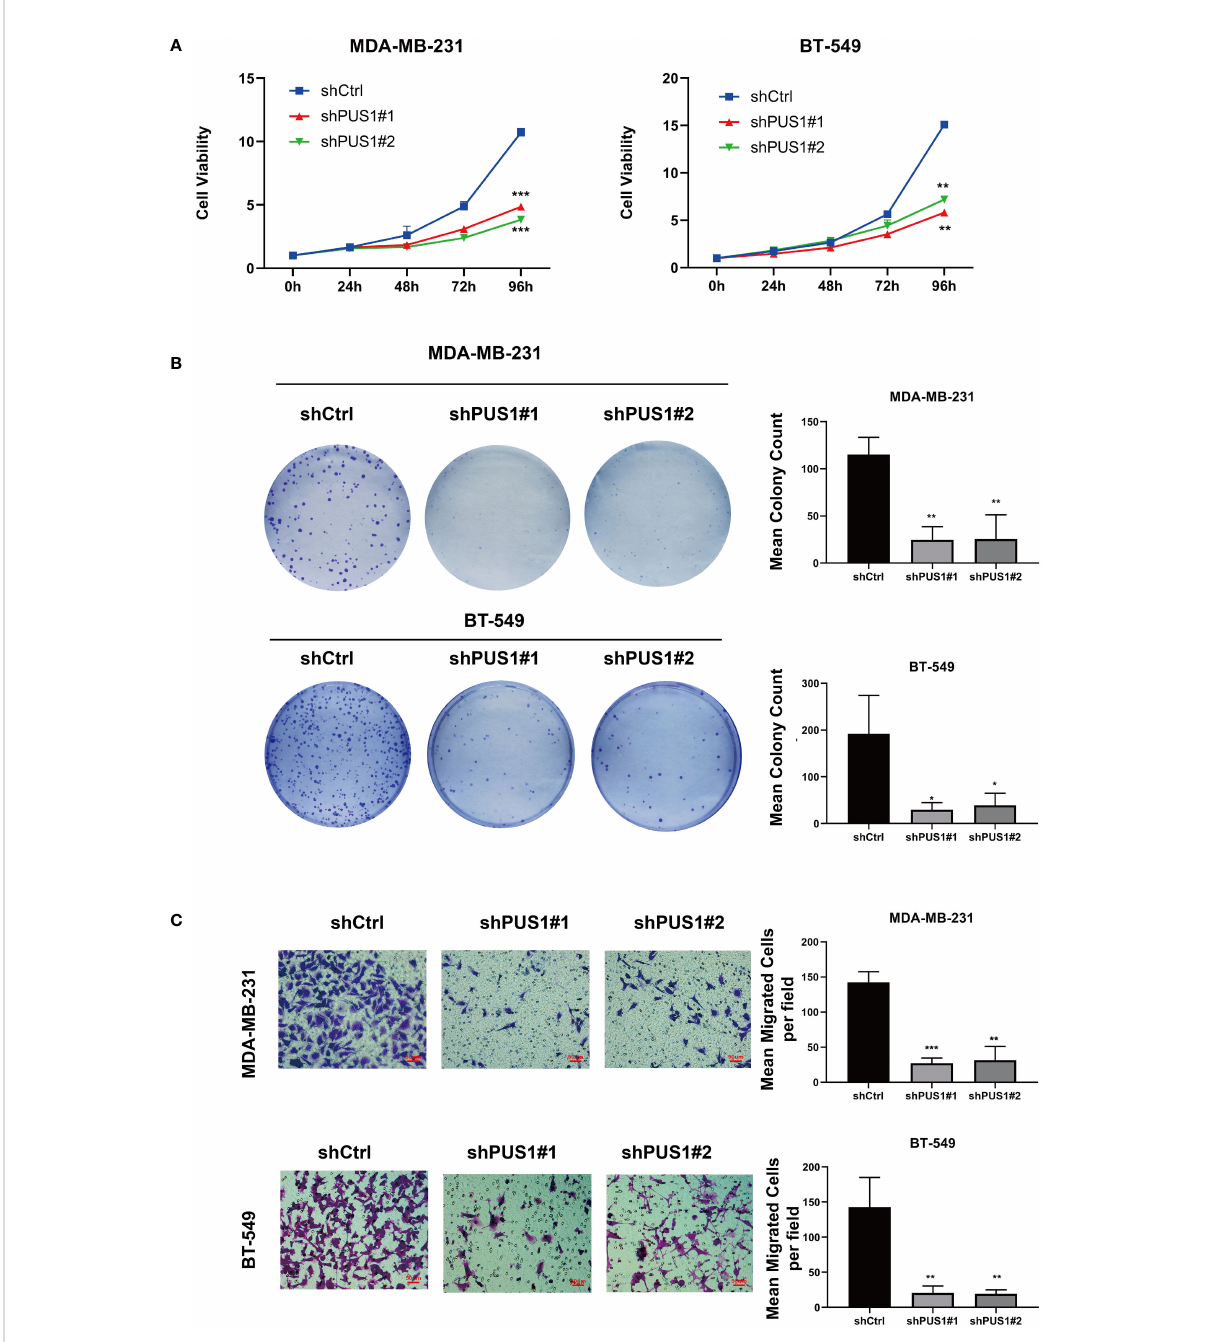
FIGURE 4 MDA-MB-231 and BT-549 cells that were knocked down for PUS1 showed decreased cell viability, colony formation, and invasion of tumor cells. (A) The cell viability of MDA-MB-231 and BT-549 determined by CCK-8 assay. The relative viability of tumor cells was signi fi cantly suppressed in the shPUS1 groups relative to the negative control groups. (B) The colony formation abilities of two cell lines examined by colony formation assay. The colonies formed by tumor cells was considerably fewer in the shPUS1 groups than in the control groups. (C) Transwell invasion assay showed that the number of tumor cells which migrated from the upper to lower chamber was signi fi cantly reduced in the shPUS1 groups compared with the control groups. The data were expressed as the means ± standard deviation with three repeats. *, P value < 0.05; **, P value < 0.01; ***, P value <